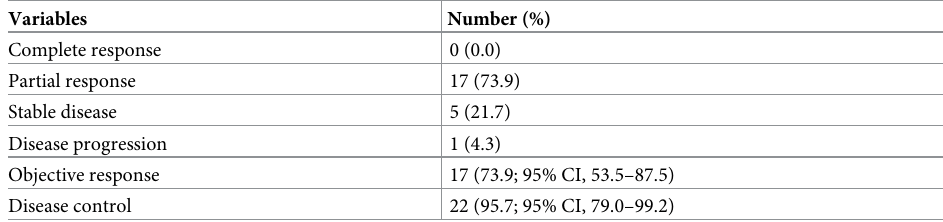
Table 2. Response to osimertinib by RECIST 1.1 in real-world practice.